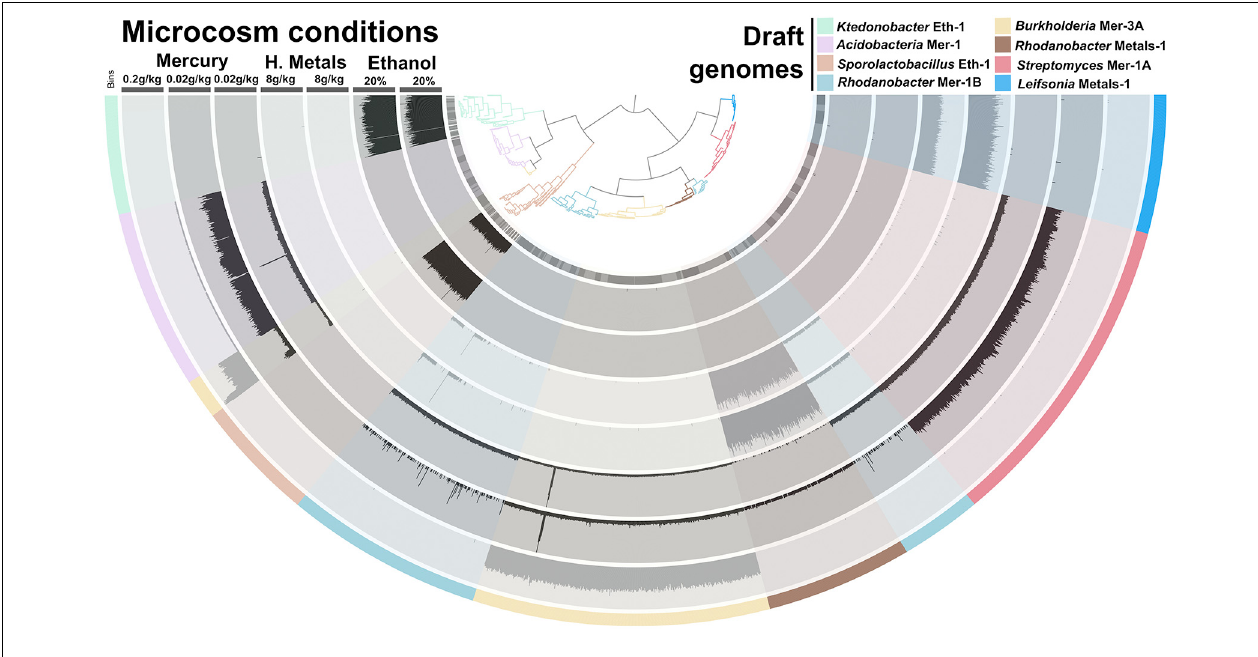
FIGURE 5 | Coverage of eight draft genomes (organized in a tree based on their tetranucleotide frequency (Euclidean distance) and fragmented into sections of 20kb) in metagenomic data representing seven microcosms and four incubation conditions. The data was generated during the first sequencing effort (paired-end sequencing). Maximum coverage varied between 30 × and 50 × depending